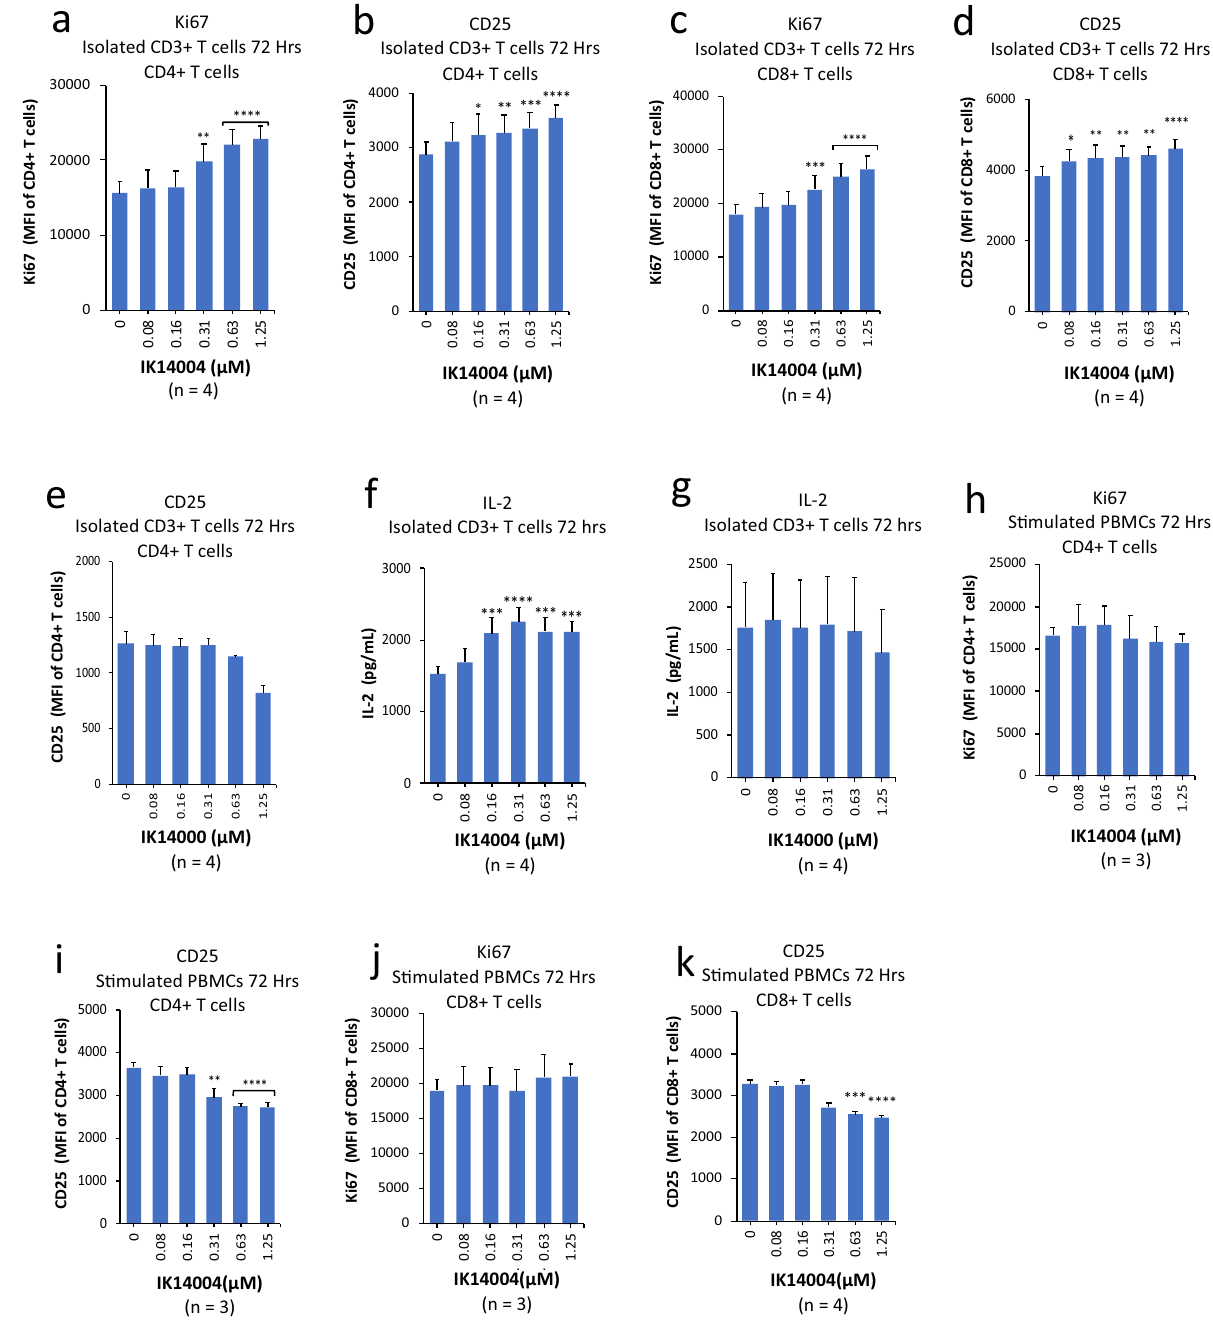
Figure 1. IK14004 enhances expression of IL-2 and CD25 in T cells in the absence of APCs. Buffy coat samples were obtained from human volunteers following ethics approval. PBMC and isolated CD3+ T cell cultures were stimulated with either anti-CD3 antibody alone or anti-CD3/anti-CD28 antibodies, respectively, as described in the “Methods”. Each tissue culture experiment was performed using triplicate wells (technical replicates) and cell-based flow cytometry/ELISA experiments were repeated at least three times (n = experimental replicates) as indicated below each panel. All error bars represent standard error of the mean (SEM). In all cell-based experiments the culture duration was 72 h. The compounds shown are IK14004 and IK14000, i.e., RSKAKNPLYR (IK14000) minus the dodecanoic acid moiety, as indicated under each panel. Flow cytometry data are shown as mean fluorescence intensity (MFI). Dot plots and gating strategies are shown in Supplementary Figs. S1 to S9. ( a ) Expression of Ki67 in CD4+ T cells within T cell cultures. ( b ) Expression of CD25 in CD4+ T cells within T cell cultures. ( c ) Expression of Ki67 in CD8+ T cells within T cell cultures. ( d ) Expression of CD25 in CD8+ T cells within T cell cultures. ( e ) Expression of CD25 in CD4+ T cells within T cell cultures exposed to peptide IK14000 lacking the dodecanoic acid moiety. The effect of dodecanoic acid residues alone could not be assessed in cell-based studies because of insolubility in physiological excipients. ( f ) IL-2 levels in supernatant from T cell cultures exposed to IK14004. ( g ) IL-2 levels in supernatant from T cell cultures exposed to IK14000. ( h ) Expression of Ki67 in CD4+ T cells within PBMC cultures exposed to IK14004. ( i ) Expression of CD25 in CD4+ T cells within PBMC cultures exposed to IK14004. ( j ) Expression of Ki67 in CD8+ T cells within PBMC cultures exposed to IK14004. ( k ) Expression of CD25 in CD8+ T cells within PBMC cultures exposed to